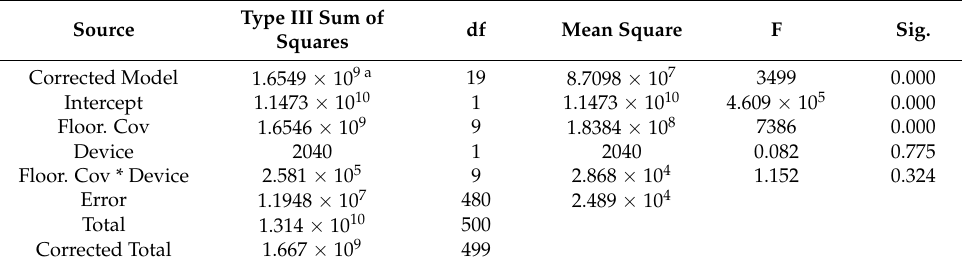
Table 2. Univariate analysis results for highest peaks, dependent variable: Highest Peaks (HP).